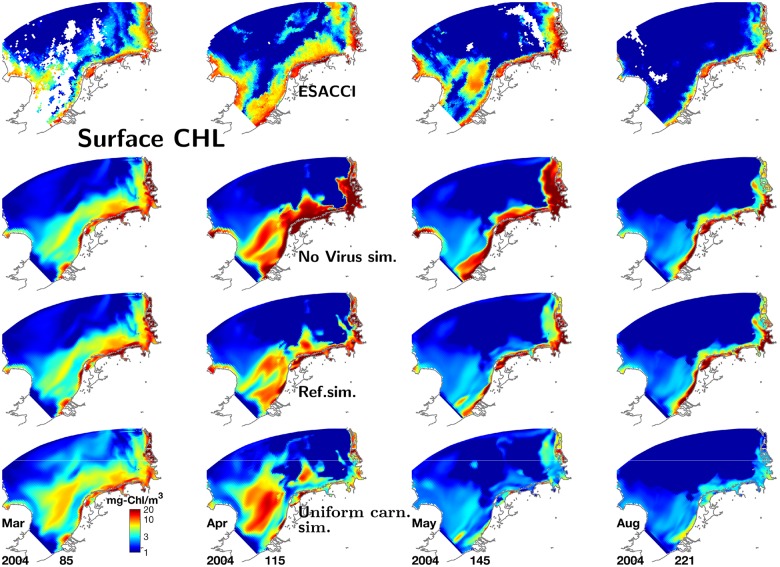
Climatological surface CHL and zooplankton.Top: Long-term (2000-2014) averaged result of the reference model (left panel) and of the version neglecting spatial gradients in carnivory (right) compared to satellite derived data (mid panel). Bottom: Long-term and vertical average of simulated zooplankton biomass for the reference and scenario run, respectively.